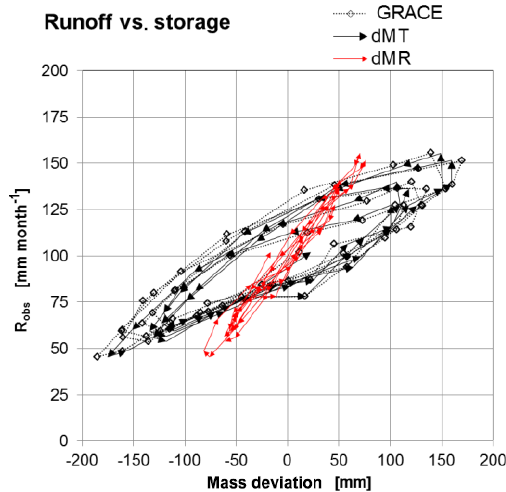
Figure 11. R – S relationships for observed runoff R o versus the mass anomalies of GRACE, calculated total mass d M T and river network mass d M R .